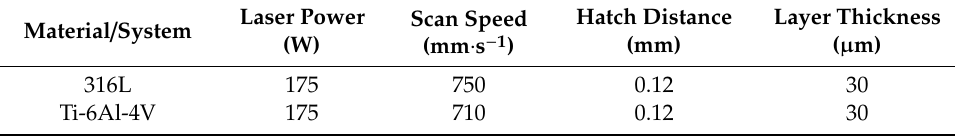
Table 3. Process parameters employed for manufacturing of the lattice structure test specimens.